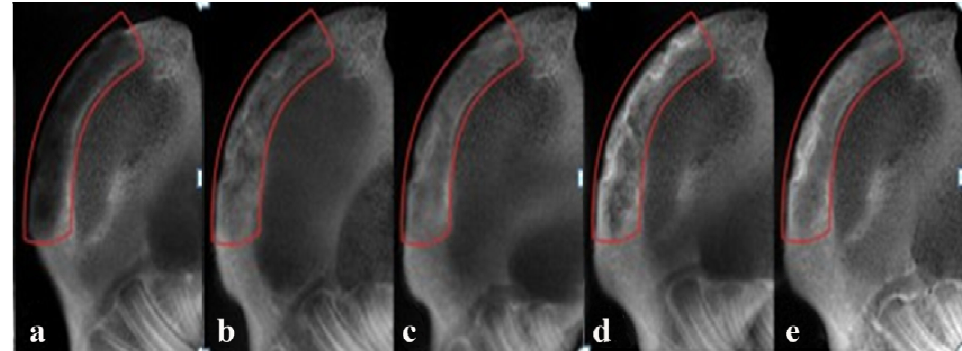
Figure 8. X-ray radiographs of large-sized mandibular defects repaired using different implants at week 12 post-implantation. ( a ) Scaffold alone; ( b ) BMSCs/scaffold; ( c ) BMSCs/bFGF/scaffold; ( d ) BMSCs/BMP-2/scaffold; ( e )